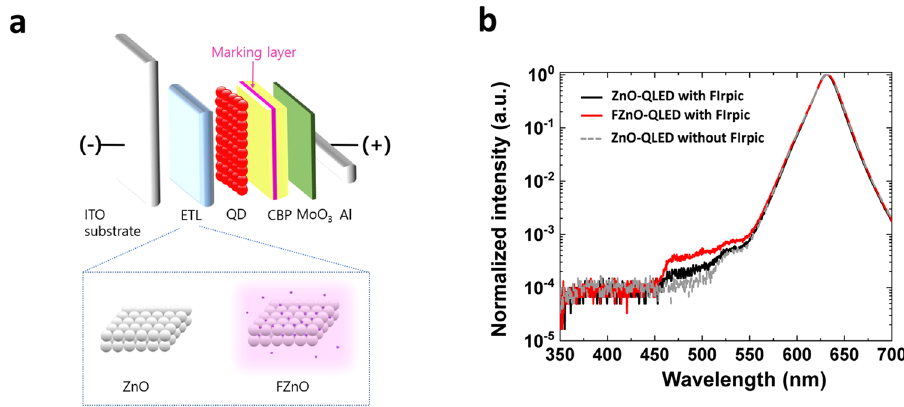
Fig. 5 a Schematic diagram depicting the structure of the QLEDs with the FIrpic marking layer. b EL spectra from the same QLEDs under 20 mA cm −2 . A spectrum from a ZnO‑QLED without the marking layer is also included for comparison